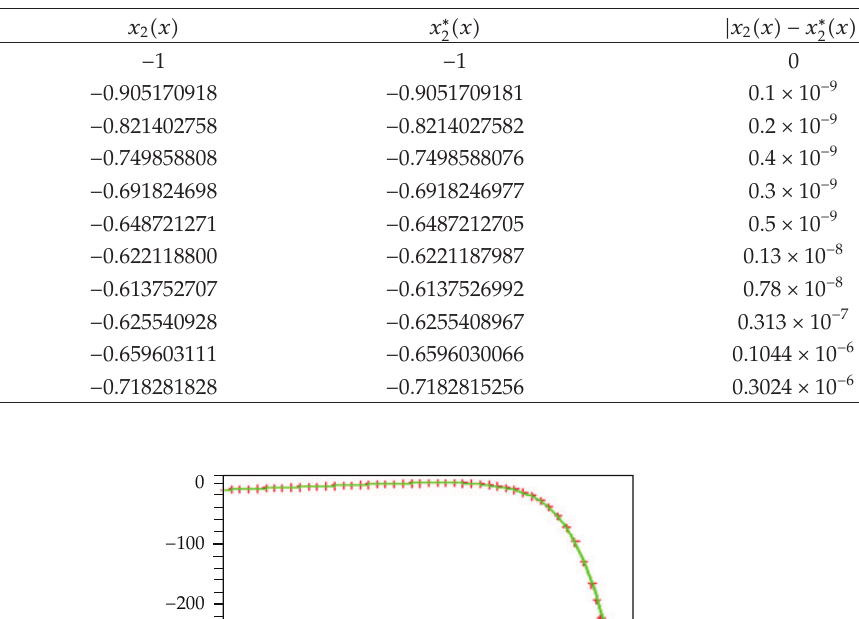
Table 2: Numerical solution of x 2 (cid:3) x (cid:4) .